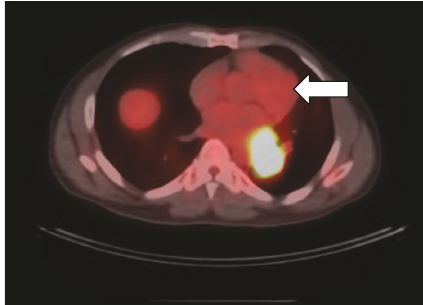
Figure 3: Poorly differentiated thyroid